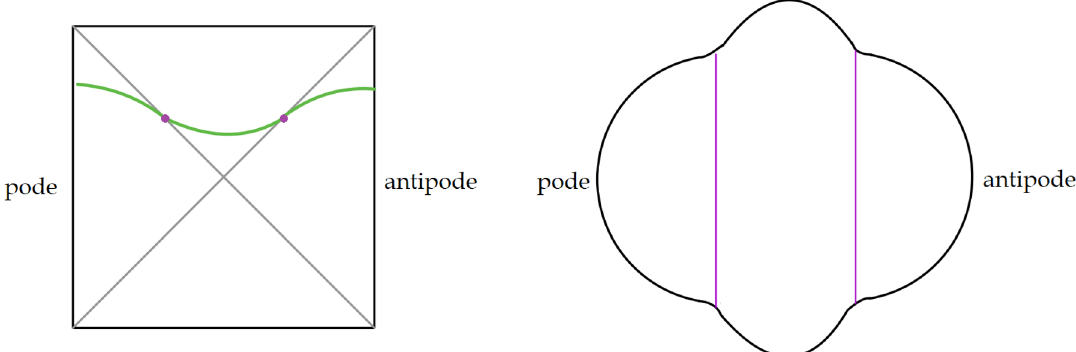
Figure 3 . A space-like slice through de Sitter space. In the static patches the slice follows constant time ( t ) surfaces until it gets near the horizons and then bends to cross the horizons. The static patches appear as hemispheres of radius R . The exterior region between the horizons bulges to a larger size due to the growth of de Sitter space in the exterior as one moves away from the